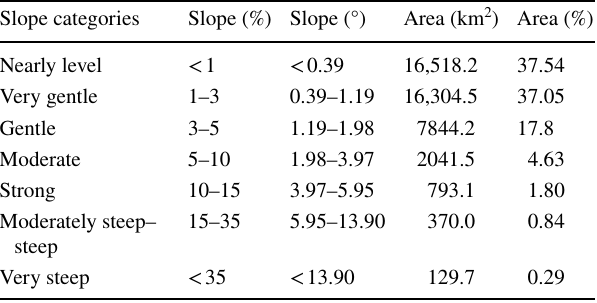
Table 7 Slope classes in Betwa River basin according to IMSD